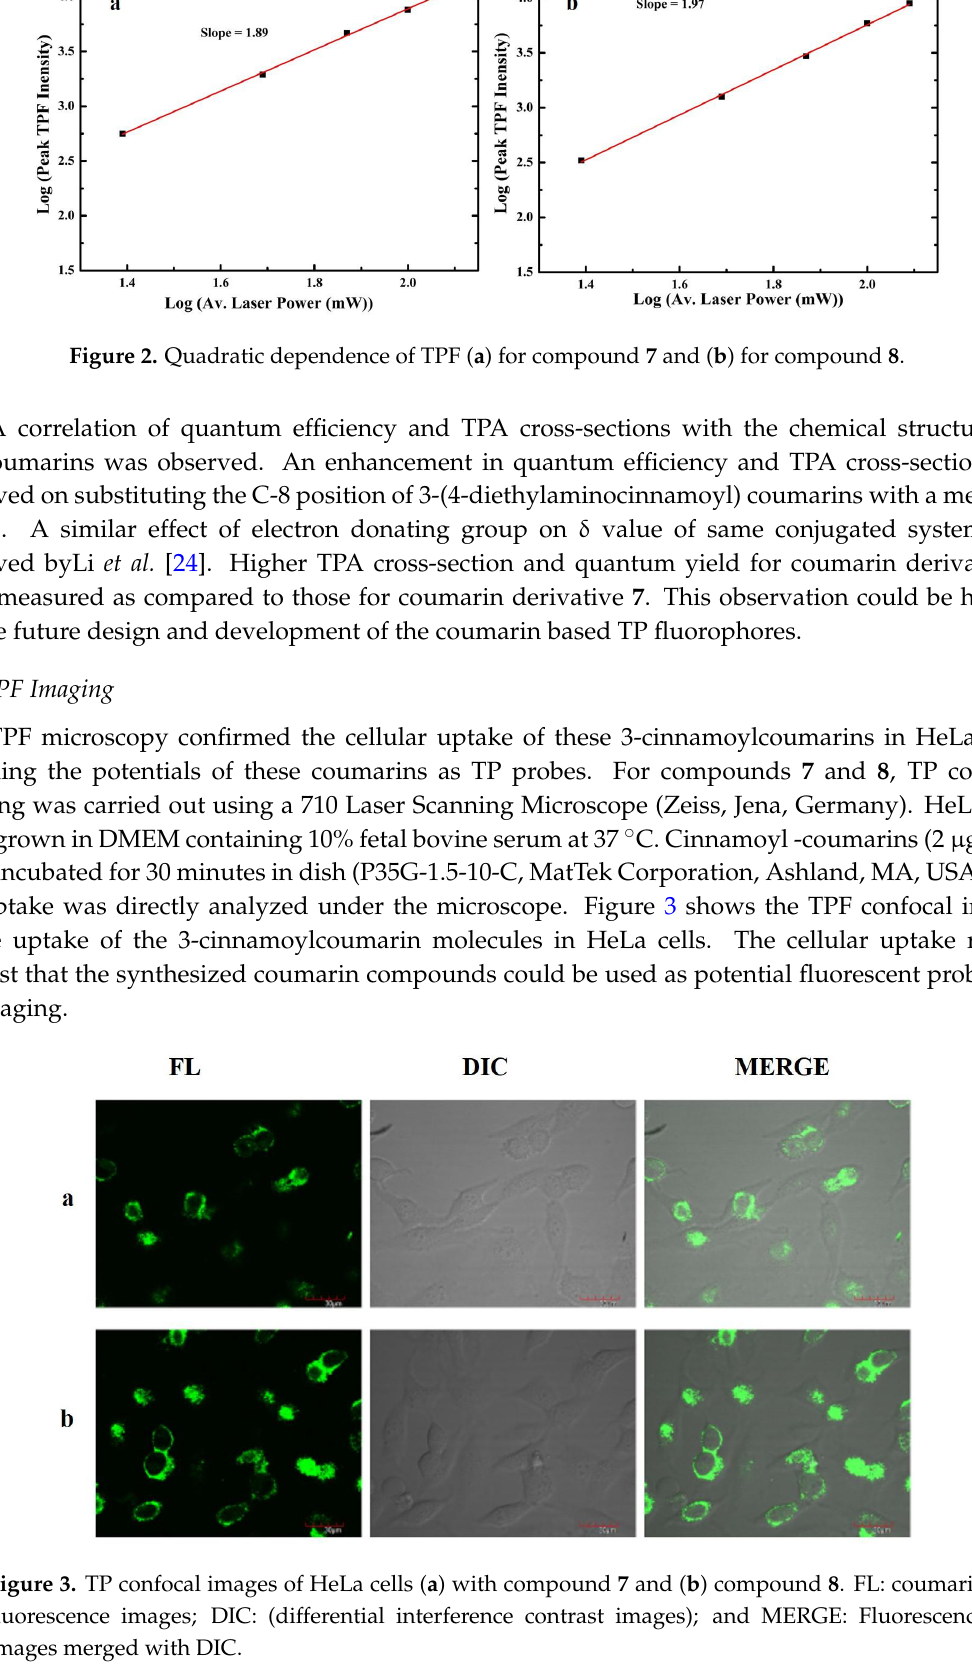
Figure 1. TPF spectra ( a ) for compound 7 and ( b ) for compound 8 .